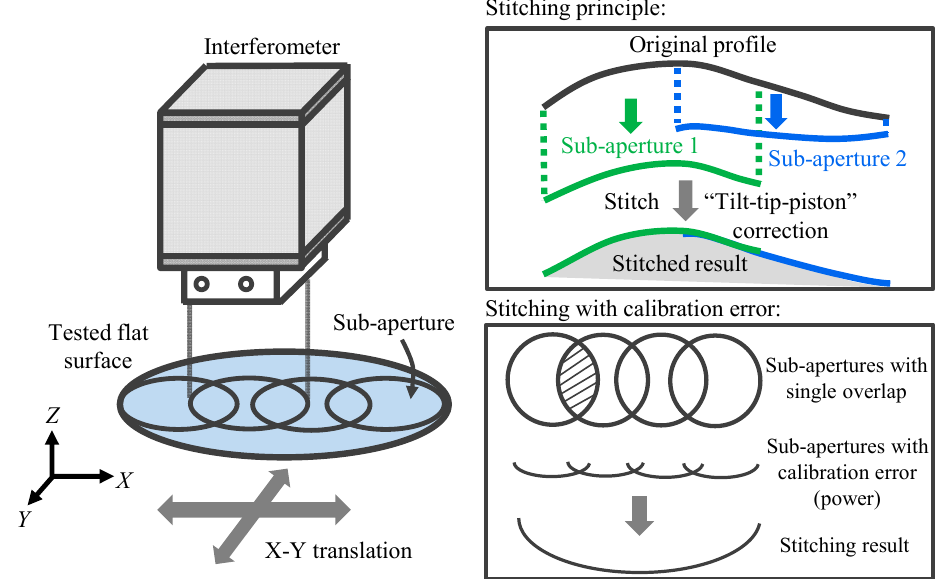
Figure 1. Schematic of the concept of the Z -directional surface form stitching interferometry and the influence of calibration error on stitching result.